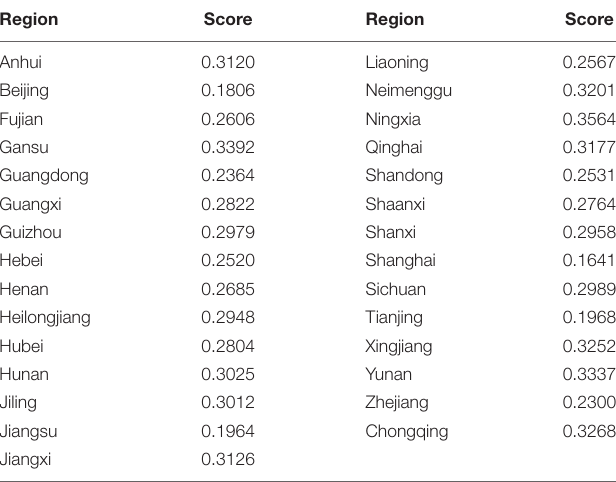
TABLE 2 | GII score of different regions.